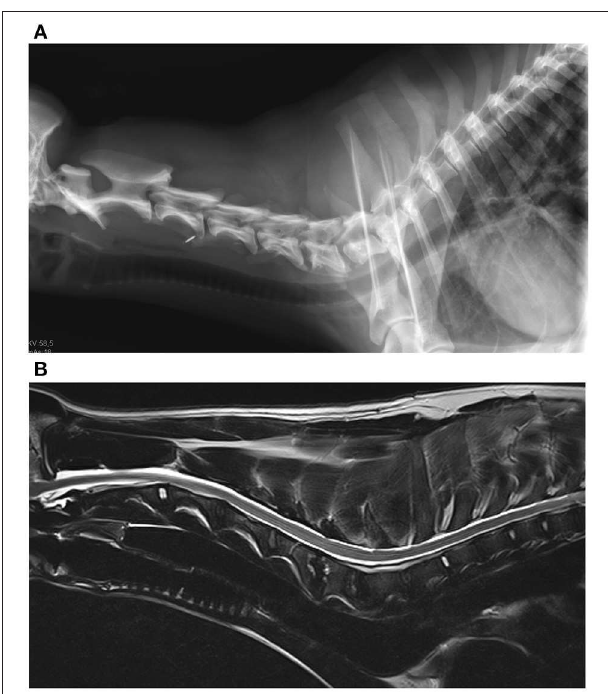
FIGURE 2 | (A) Radiograph of the cervical spine of a dog with Brucella canis discospondylitis. There is lysis of the caudal vertebral end plate of C4 and the cranial end plate of C5 and bone production around the periphery of the vertebral bodies. (B) Magnetic resonance images of the same dog. Sagittal T2-weighted image of the cervical spine. The caudal end plate of C4 and the cranial end plate of C5 appear hyperintense to adjacent vertebral bodies, the intervertebral disc space appears narrowed. The caudal endplate of C5 and the cranial end plate of C6 also show similar lesions, but in a milder condition